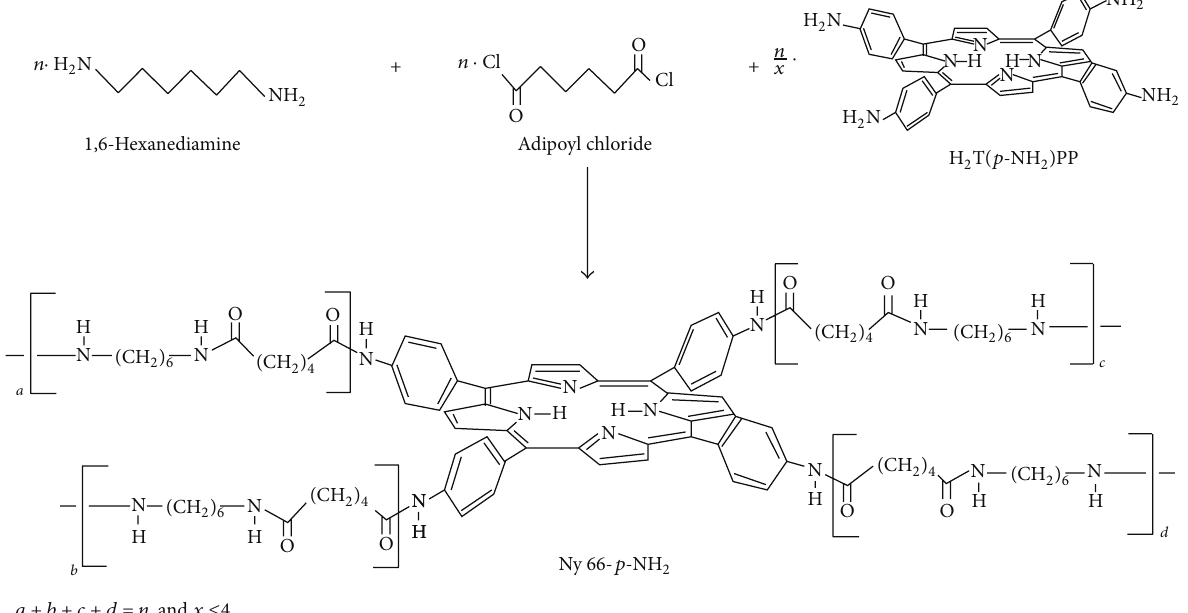
Figure 4: Synthesis route for the incorporation of the H 2 T( o - or p -NH 2 )PP species into the Nylon 66 network; the 𝑎 , 𝑏 , 𝑐 , and 𝑑 subindexes are related to the lateral chains formed over the amine groups of porphyrin, which could attain the same or different sizes.